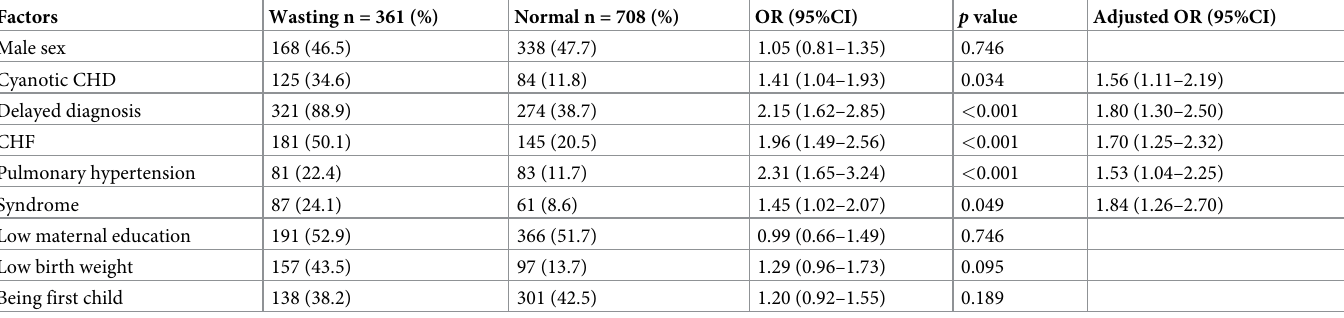
Table 4. Factors associated with wasting.